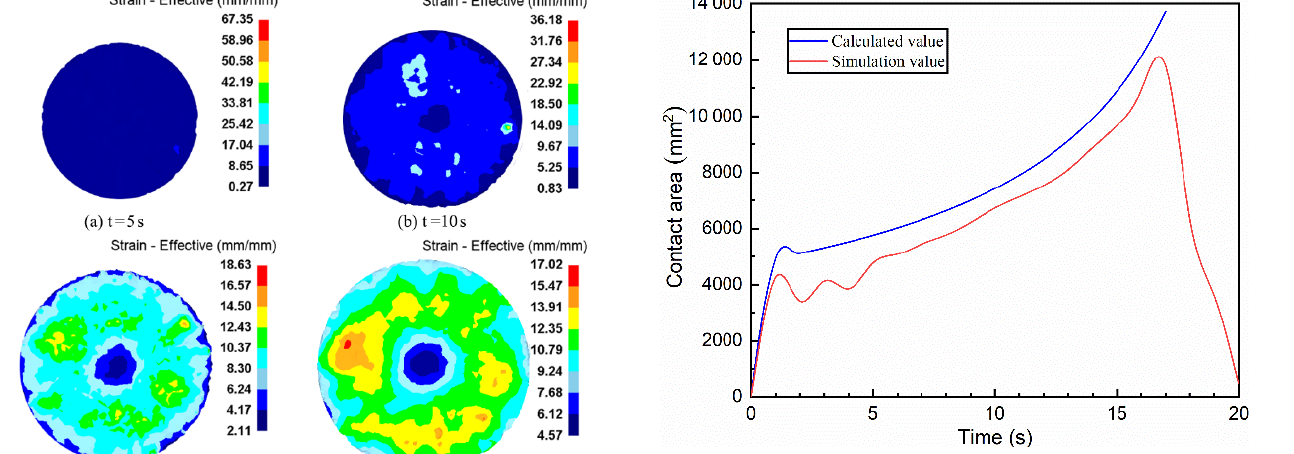
Figure 14. Comparison of the contact area between the cone rolls and the workpiece between theoretical calculation and